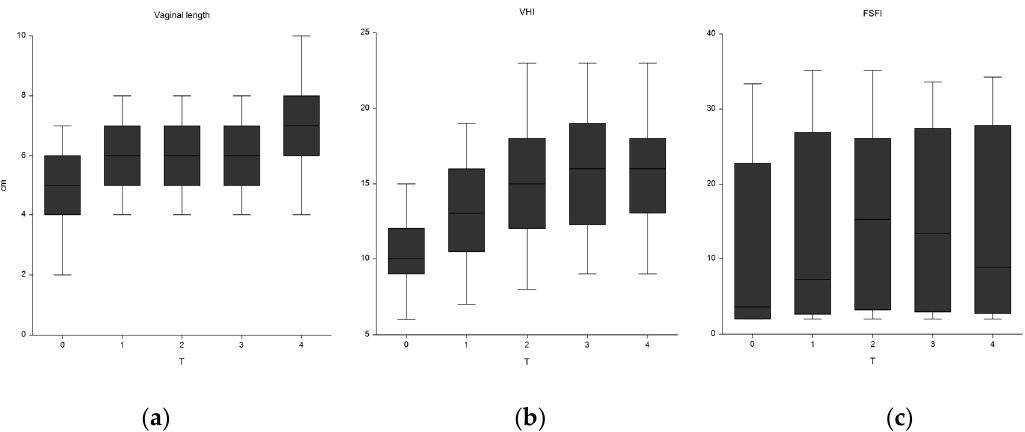
Figure 3. Clinical and functional improvement during treatment and follow-up of: ( a ) vaginal length, ( b ) vaginal health index (VHI), ( c ) female sexual function index (FSFI).